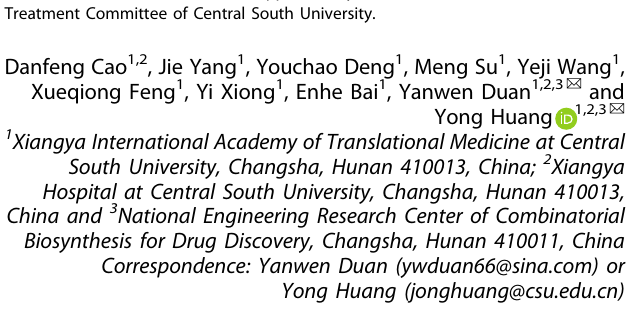
Fig. 1 Discovery of 6p against NSCLC and melanoma. a Identi fi cation of 6p from 107 semisynthetic platensimycin derivatives prepared in our previous studies. b IC 50 values of FASN inhibitors TVB-3166, orlistat, cerulenin, and 6p against cancer cell lines A549, NCI-H1299, A375, as well as normal cell lines BEAS-2B and NCM-460. The selectivities of 6p against A549 and NCI-H1299 towards normal cells were 3.21 and 2.21, respectively ( n = 4). c Inhibition of colony formation in A549 and NCI-H1299 cells treated with 6p alone or in combination with cis-platinum (CDDP) ( n = 3). d Inhibition of NCI-H1299 cell migration and invasion by 6p in the transwell assay ( n = 3). e The predicted docking mode of 6p (green) in human FASN KS-MAT didomain (PDB ID: 3HHD). f Molecular dynamics simulation showing the non-bond interaction energies. 6p was in red and platensimycin (PTM) was in black. g The IC 50 values of 6p against A549 and NCI-H1299 cells in RPMI medium containing 10% (blue) or 1% fetal bovine serum (red). h Cell growth was rescued by exogenous free FAs (oleic acid: palmitic acid = 2:1), Two-way ANOVA test ( n = 6), ### p < 0.001 6p + free FAs versus 6p . i Determinat i on of FASN expression levels in A549, NCI-H1299, and BEAS-2B. j Western blotting showed the decreased FASN expression by 6p treatment in A549 and NCI-H1299 cell lines (n = 3). k The reduced FASN expression in cytoplasm under confocal microscopy in NCI-H1299 cells treated by 6p . l RNA-seq analysis of NCI-H1299 cells treated with 6p (25 μ M) showed down-regulation of key genes involved in DNL and cholesterol synthesis ( n = 3). m RT-qPCR results showed that 6p decreased the expression of key DNL genes, One-way ANOVA test ( n = 3). n Western blotting showed the decreased SREBP-1c expression by 6p treatment in A549 and NCI-H1299 cells. pSREBP-1c: SREBP-1c precursor; mSREBP-1c: mature forms of SREBP-1c. o The down-regulation of PI3K-AKT-mTOR signaling pathway by 6p treatment in A549 and NCI-H1299 cells ( n = 3). p Lipidomic analysis showed that 6p (25 μ M) changed the total intensity fold changes of individual fatty-acyl chains associated with total triacylglycerides sorted by degree of saturation. SAF, saturated fatty acyls; MUFA, monounsaturated fatty acyls; PUFA, polyunsaturated fatty acyls; ODD, odd-numbered fatty acyls ( n = 5). q, r The tumor volume ( q ) and tumor weight ( r ) were signi fi cantly reduced when A549 tumor xenografts were treated with 6p , and the combination treatment of 6p and CDDP inhibited tumor growth synergistically. Two-way ANOVA test ( q ), One-way ANOVA test ( r ) ( n = 5). s Western blotting showed that 6p decreased the expression of p-AKT and FASN in A549 tumor xenografts ( n = 5). t, u The tumor volume ( t ) and tumor weight ( u ) were signi fi cantly reduced when A375 tumor xenografts were treated with 6p . Two-way ANOVA test ( t ), One-way ANOVA test ( u ) ( n = 5). v The proposed mode of inhibition of FASN by 6p , which decreased the expression of key lipogenic genes (labelled in green), and downregulated the PI3K-AKT- mTOR oncogenic signaling; exogenous polyunsaturated and odd-numbered FAs were transported to the cells as a compensating mechanism to sustain cell survival. Data were shown as means ± SD, * p < 0.05; ** p < 0.01; *** p <